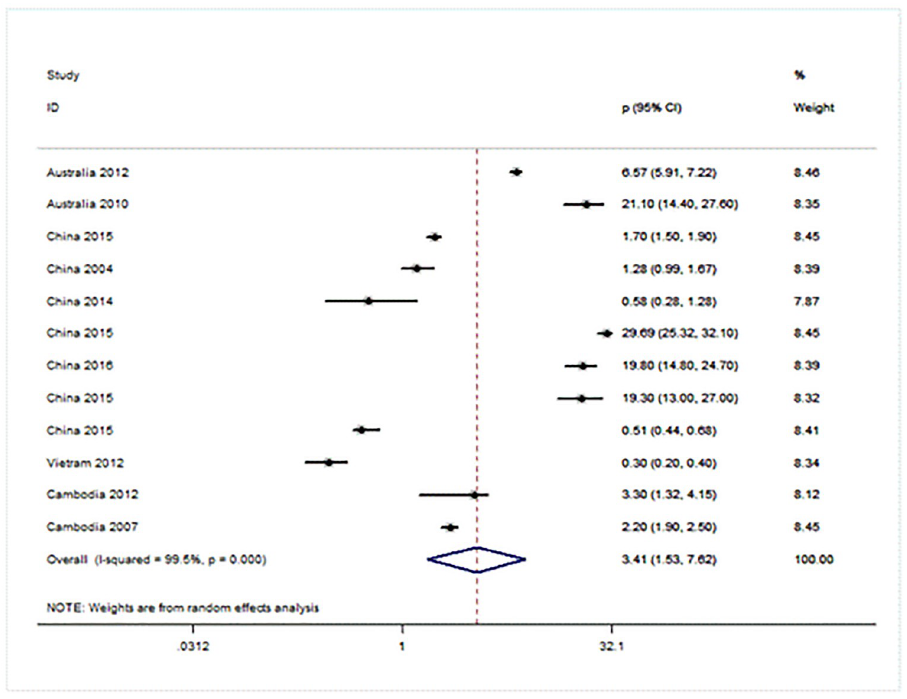
Fig 4. Crude prevalence of myopia, hyperopia and astigmatism by age in gender. The broken line are informative data points from included studies that reported the prevalence of URE.